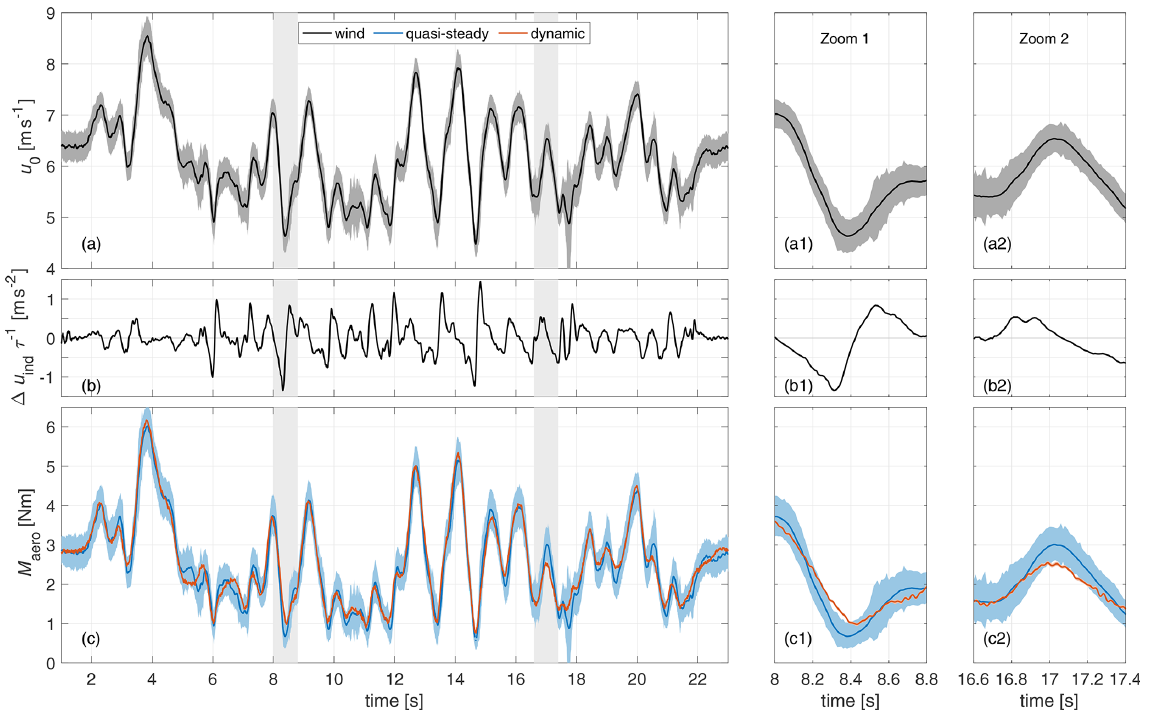
Figure 8. Stochastic wind variation (a) , difference quotient of velocity with τ to obtain the instances of largest relevant velocity change (b) , and flapwise blade root bending moment (c) for the steady case and dynamic case. Furthermore, two zoomed-in views (marked in grey in the whole time series) of situations of interest of the same data series are presented (a1, a2, b1, b2, c1, c2)